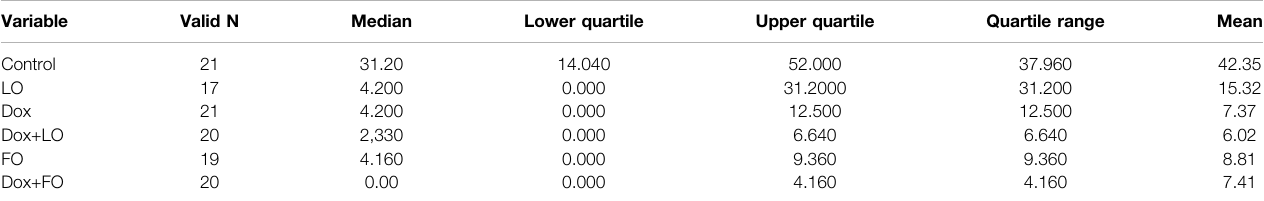
TABLE 3 | Descriptive statistics for the studied groups of animals according to values on the volume of LLC tumors after 12 days from the start of treatment. Variable Valid N